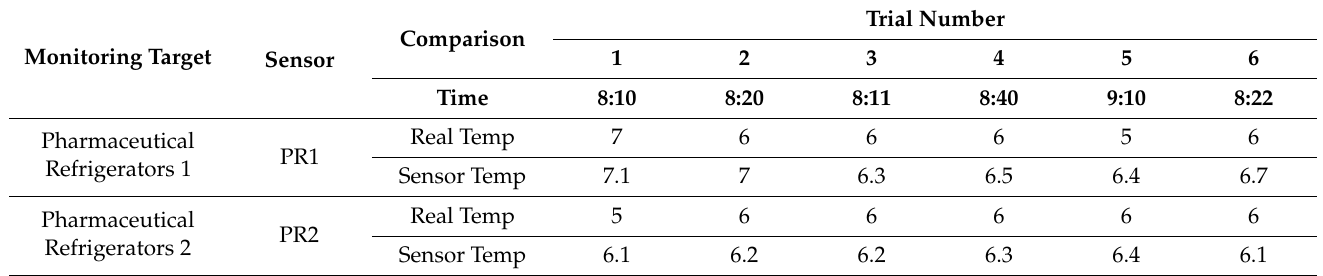
Table 7. Temperature of Pharmaceutical Refrigerators Monitored with Non-Hospital Network.